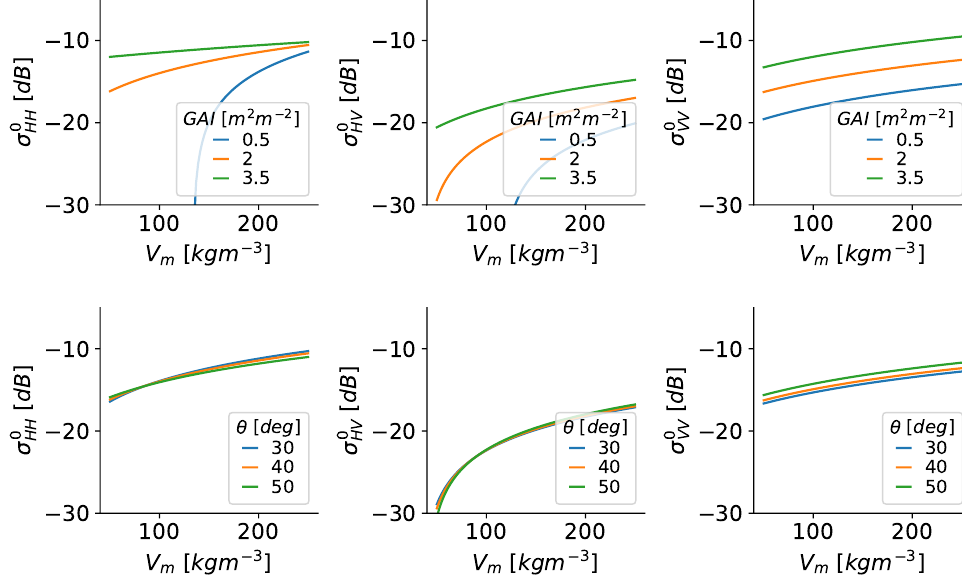
Figure 8. Backscattering coefficient simulations σ 0 in polarization HH, HV, and VV as a function of volumetric surface soil moisture, V m , ( top ) for multiple values of GAI with the incidence angle θ = 40 ◦ , and ( bottom ) for multiple incidence angles with GAI = 2m 2 m − 2